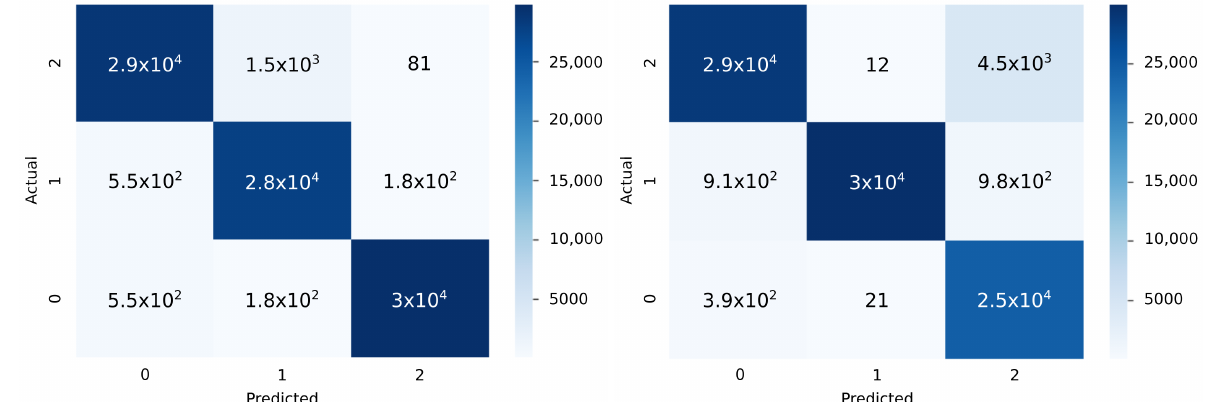
Figure 15. Block diagram illustrating the test design used for the experiment.